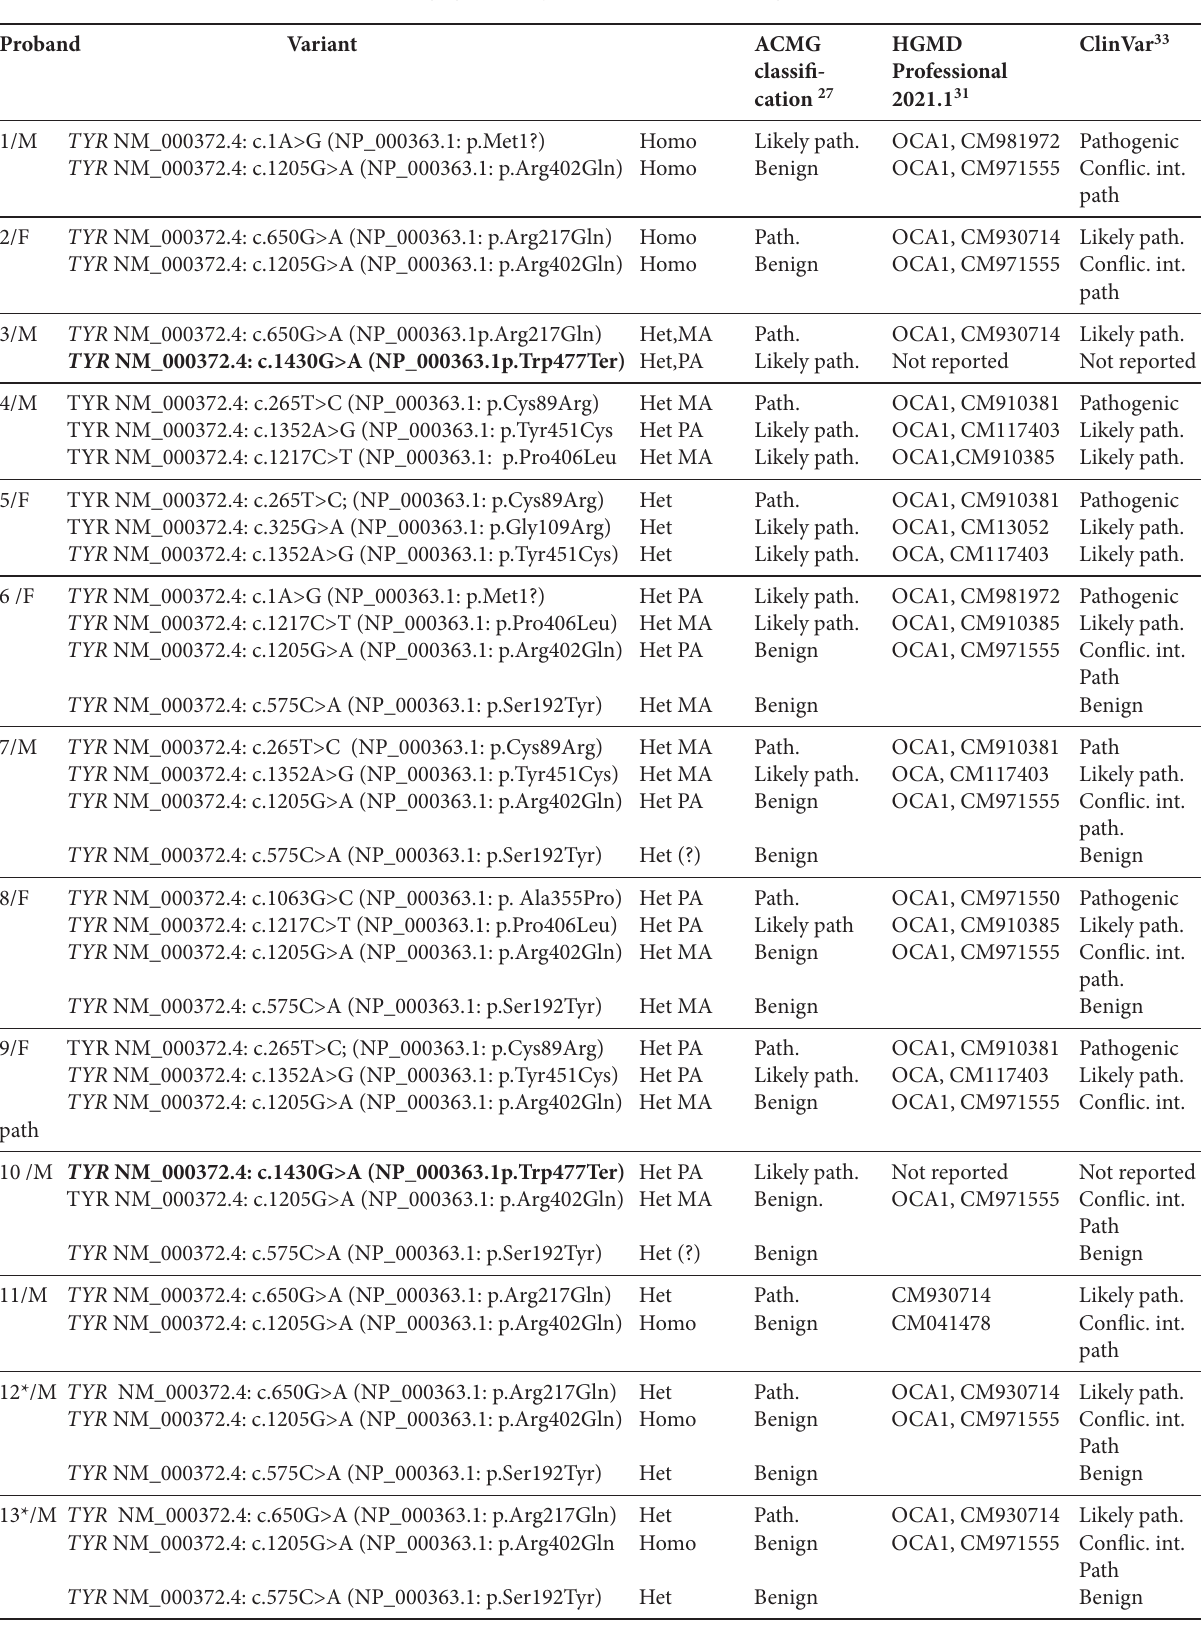
Table 2: Genetic variants detected in OCA patients (novel variants are in bold; M: male; F: female; homo: homozygous variant; hetero: heterozygous variant; PA-paternal allele, MA-maternal allele, ? segregation analysis was inconclusive; * siblings.).